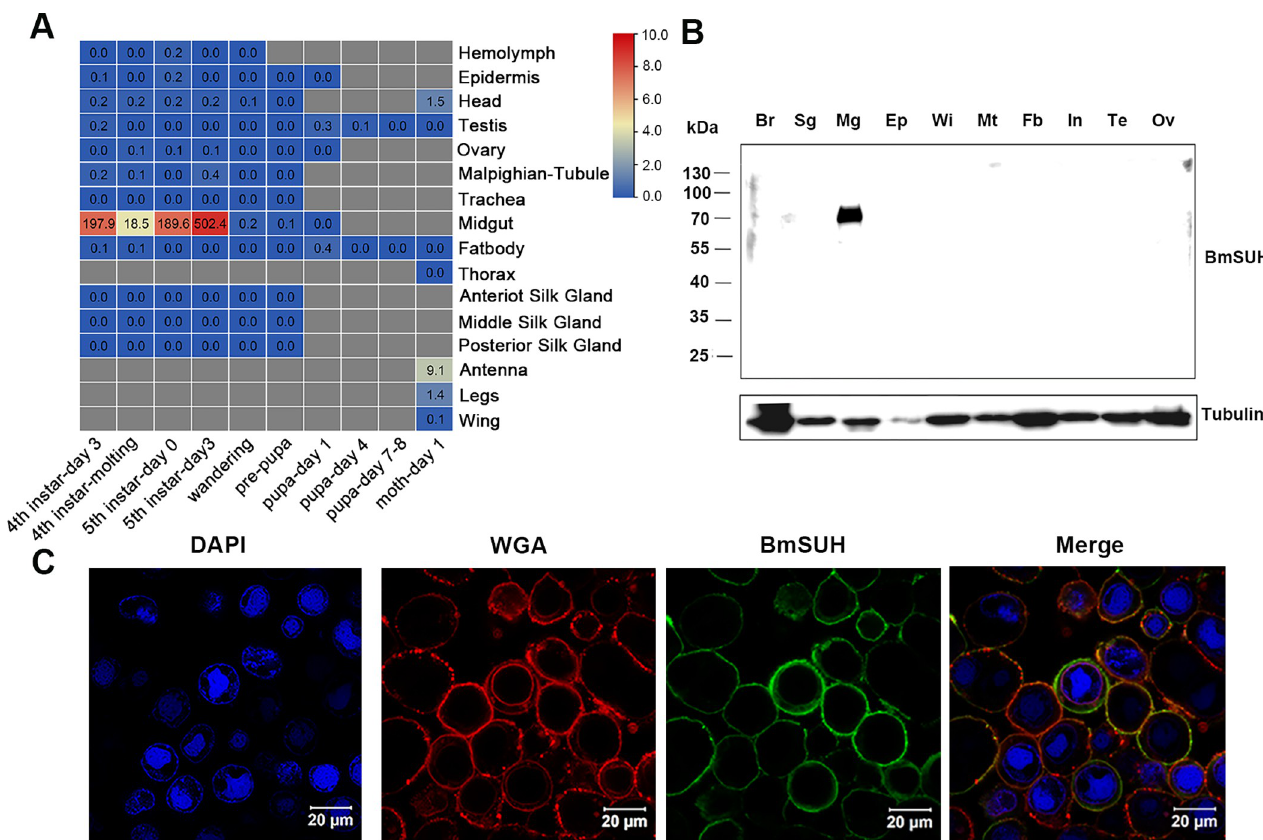
Fig 1. BmSUH is a membrane-associated midgut protein. (A) Expression patterns of BmSUH mRNA in B . mori expression data from SilkDB 3.0 (https:// silkdb.bioinfotoolkits.net). (B) Expression profiles of BmSUH in the third day of fifth instar larvae (L5D3). Immunoblot analysis were performed using antibody against BmSUH and α -Tubulin as a loading control. Protein samples were isolated from brain (Br), silk gland (Sg), midgut (Mg), epidermis (EP), wing disc (Wi), Malpighian tube (Mt), fat body (Fb), integument (In), testis (Te), and ovary (Ov). (C) Subcellular localization of BmSUH in BmN cells. BmSUH was expressed in BmN cells by transfection. Antibody specific to BmSUH was used for immunofluorescence and green fluorescence (FITC) was observed as a marker. The cytoplasmic membrane was stained red using WGA-AF 594 and nuclei were visualized using 4’,6’-diamidino-2-phenylindole (DAPI, blue)